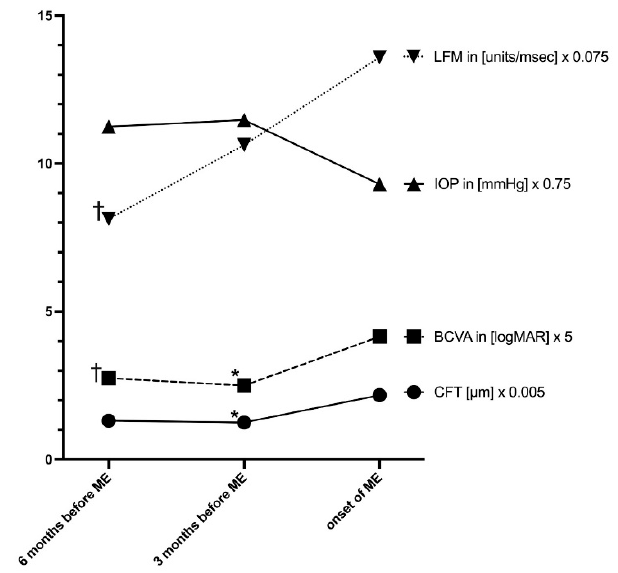
Figure 2. Central foveal thickness (CFT), laser-flare photometry values, best-corrected visual acuity (BCVA), and intraocular pressure (IOP) in patients with juvenile idiopathic arthritis-associated uveitis at 6 months, 3 months before, and at onset of macular edema. Adjusted p -value (posthoc analysis for significant parameter) 3 months before ME onset vs. ME onset (* p < 0.05); 6 months before ME onset vs. ME onset († p < 0.05).